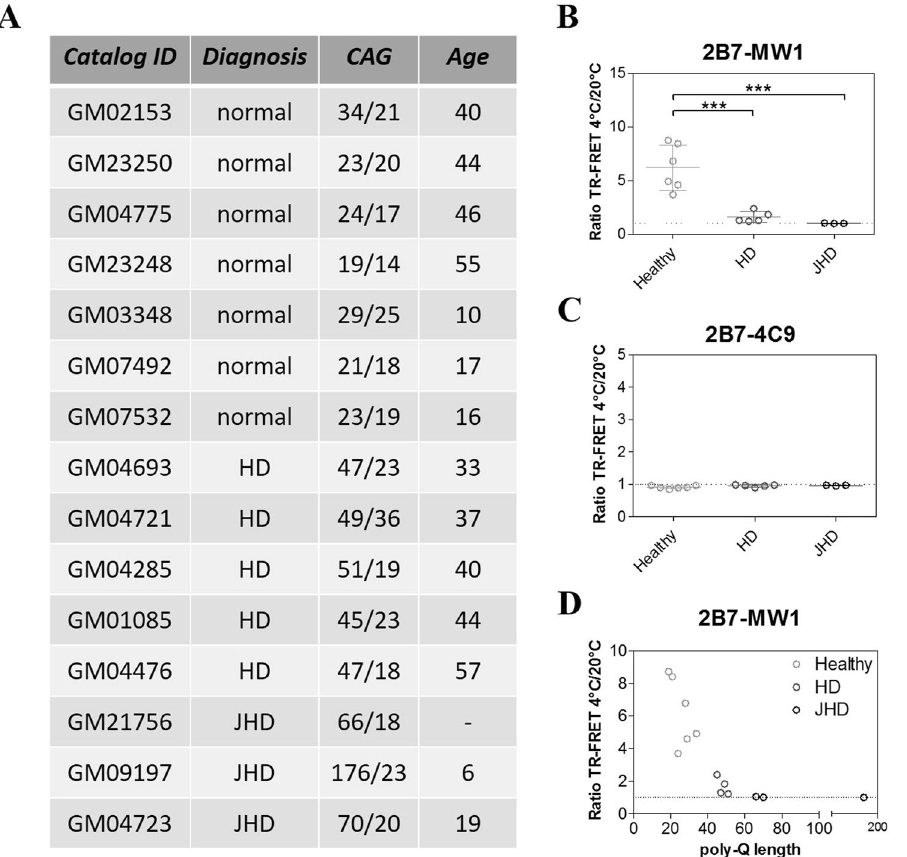
The 2B7/MW1 TR-FRET conformational immunoassay, applied to brain tissue samples collected from the heterozygous mouse knock-in (KI) HD model (Q7/Q111) 40 , successfully detected the presence of mHTT and revealed the expected lack of conformational flexibility (data not shown). However, the TR-FRET assay did not detect HTT in knock-in mice harboring a humanized HTT exon 1 with a CAG 7 repeat (Q7/Q7) 41 , as expected and previously reported 23 . Although we had no access to alternative mouse models expressing a wild type HTT with a polyQ length larger than Q7 and a corresponding mutant HTT protein, samples were available from a characterized Drosophila HD model expressing a large Amino-terminal (N469) fragment of human HTT with either Q25 or Q120 9 . HTT levels were investigated in these samples using the 2B7/MW1 and 2B7/4C9 TR-FRET immunoassays, and as expected the 2B7/MW1 assay revealed a polyQ-dependent signal (higher signal in ani- mals expressing HTT with a mutant expansion) relative to flies expressing wild type HTT (Fig. 6Aa), while the 2B7/4C9 assay detected comparable HTT levels irrespective of polyQ length (Fig. 6Ca). Significantly, the 2B7/ MW1 TR-FRET conformational immunoassay detected a strong conformational difference between lysates from HD Tg flies and control Tg flies (Fig. 6Aa,b and B). No such differences were observed with the control 2B7/4C9 TR-FRET immunoassay (Fig. 6Ca,b and D). These data indicate that the 2B7/MW1 TR-FRET based conforma- tional immunoassay can effectively detect the conformational constraint imposed by polyQ expansion on HTT in animal models of HD. Interrogation of mutant huntingtin conformation in peripheral cells and post-mortem brain tissue from control and HD individuals. Next, we sought to determine the potential translational value of the 2B7/MW1 TR-FRET conformational immunoassay, by interrogating biological samples of clinical rele- vance, namely samples of peripheral (lymphocytes) and central (post-mortem brain tissue) origin from control